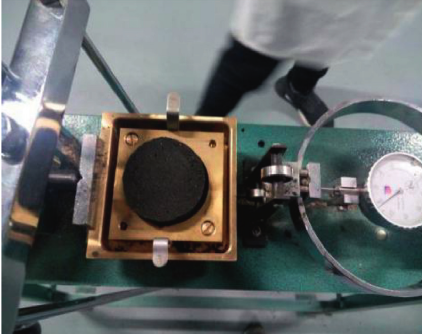
Figure 6: Failure model of test